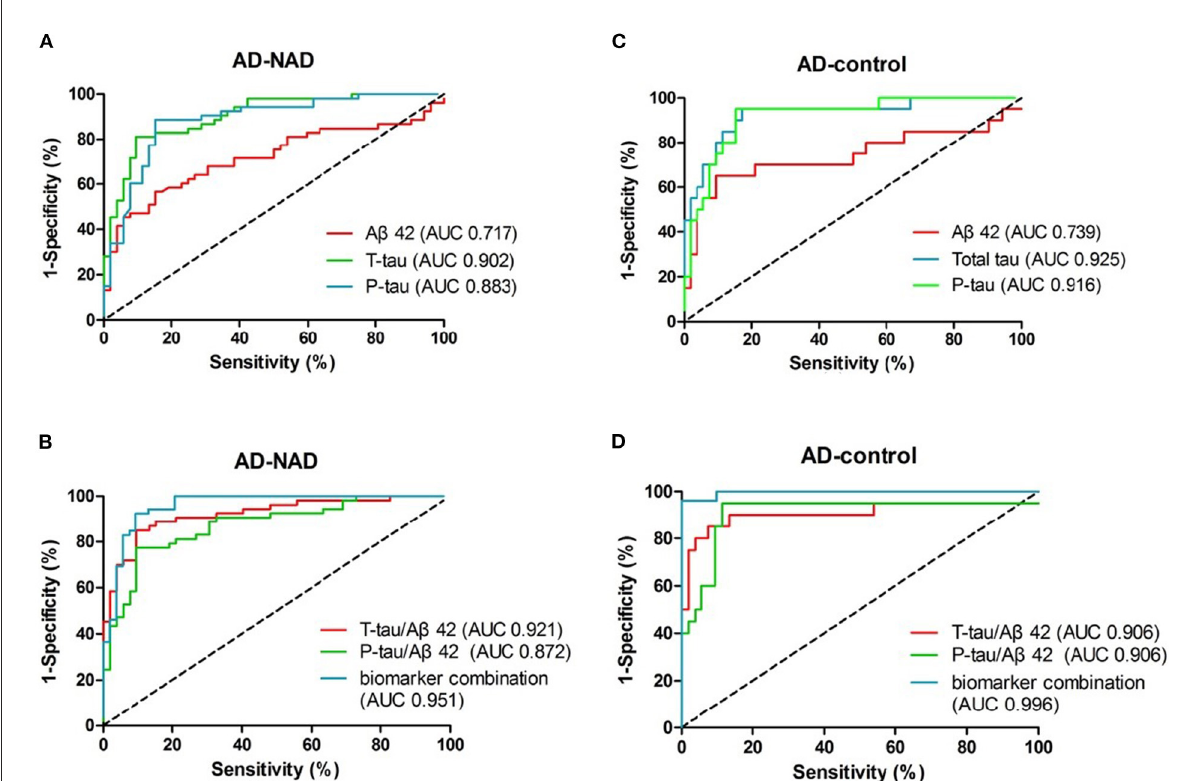
FIGURE3 ROC curves of CSF biomarkers in the early-onset group. (A, C) depict curves of the original biomarkers. (B, D) Display the curves of the calculated ratios and the generated predicting factor, respectively. Diagnostic accuracy, the area under the curve (AUC), is labeled in the legend.